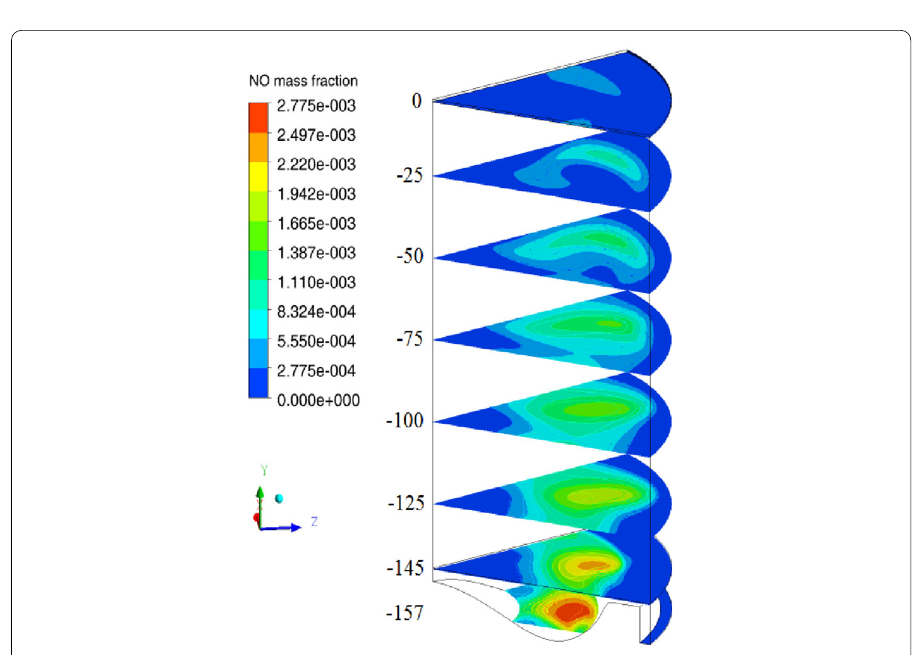
Fig. 8 Contours of NO mass fraction at 833 ◦ CA (scale in figure is in milimeters)